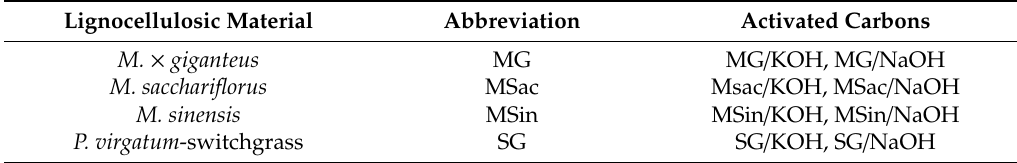
Table 1. Lignocellulosic materials and derived activated carbons obtained in the